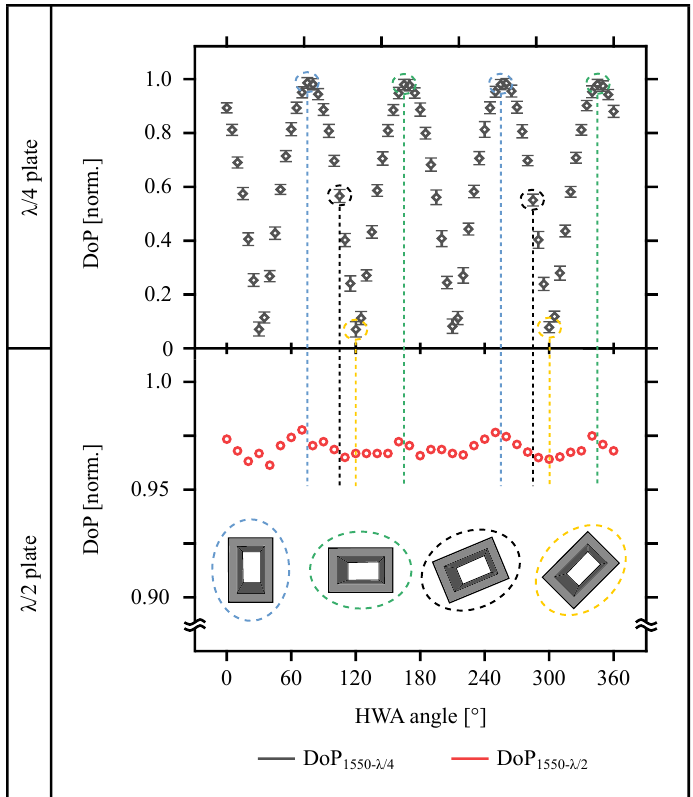
Figure 8. Degree of Polarization against the hollow waveguide array (HWA) angle for a quarter-wave plate (top) and a half-wave plate (bottom). For a clear presentation, the results for the half-wave plate is only plotted in steps of 10 ◦ . The schematic drawings of the hollow waveguides in the figure show the orientation of the waveguides for selected positions. These positions are marked in color in the figure. Please note, because of the smaller amount of measurement values for the half-wave plate, no measured value is given for some